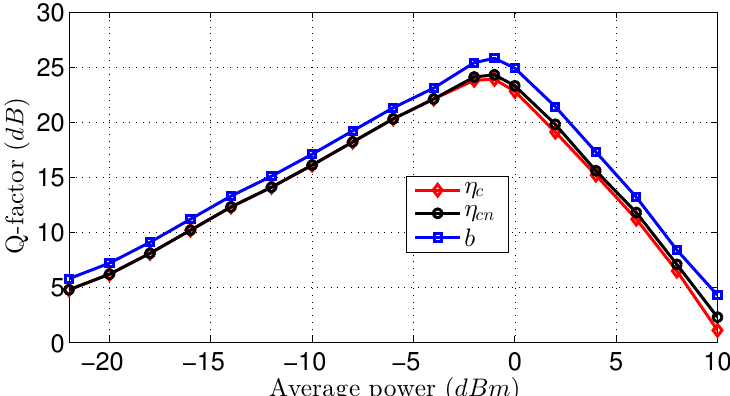
Figure 6. Q-factor versus input average power for all three modulations for a 50 Gbaud QPSK modulation over 1600 km of optical fiber. In blue line is shown the b-modulation; in black line, we show the modulation with a normalized reflection coefficient η c , n , given in Equation (64), and in red line, the normal modulation with reflection coefficient η c , n , given in Equation